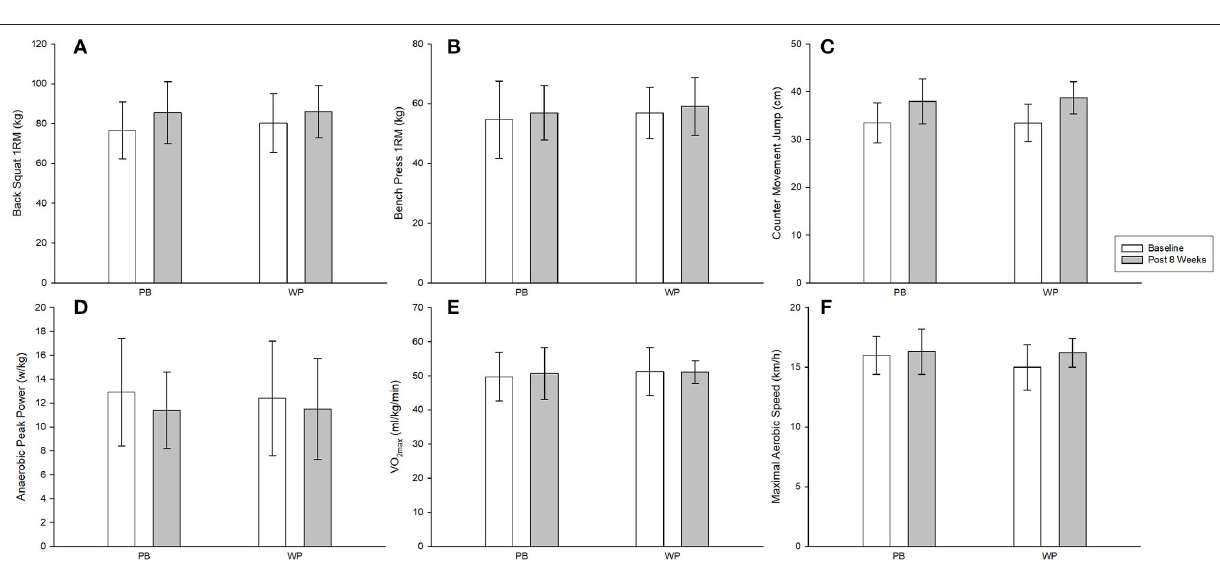
FIGURE 3 | Performance markers at baseline and post 8 weeks: back squat (A) , bench press (B) , counter movement jump (C) , anaerobic peak power (D) , VO2max (E) and maximal aerobic speed (F) . PB, plant-based protein; WP, whey